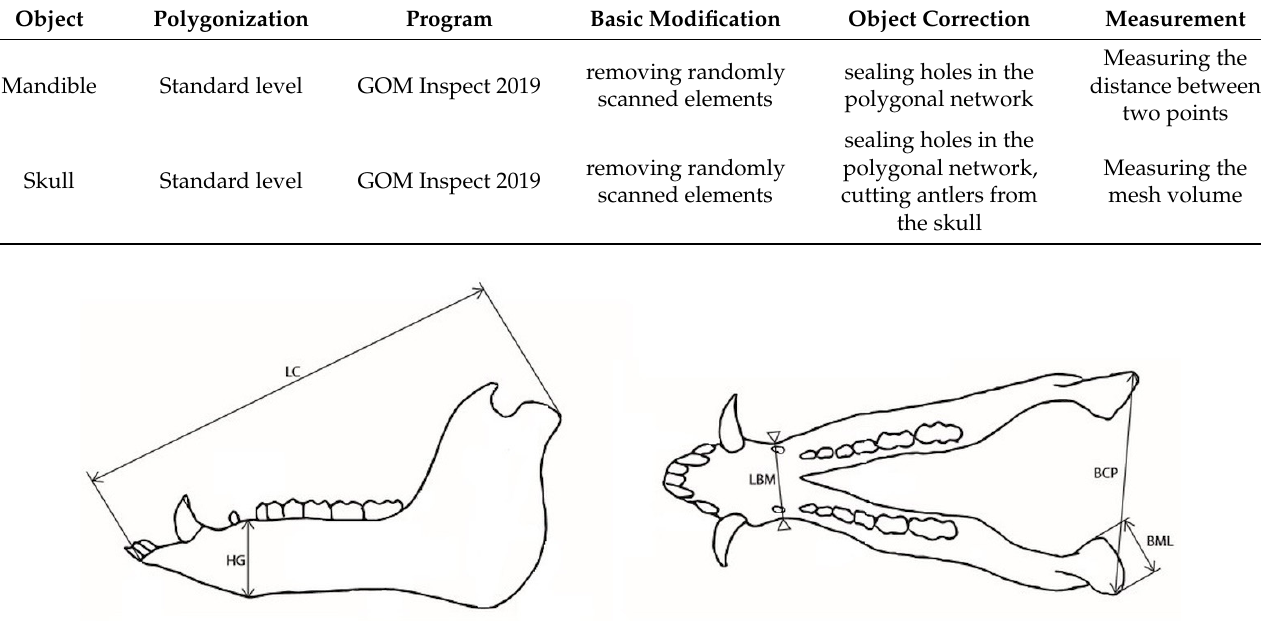
Figure 4. Dimensions measured on the mandible. Notes: LC—length of the cranium (condylobasal length), from the front part of pars incisive to anterior-most point of the processus condylaris; HG—height of the mandible, from the bottom of the symphysis mandibulae to the top of the margo interalveolaris; LBM—minimum breadth of the mandible; BCP—breadth of the mandible, between the borders of the medial and lateral points of the caput mandibulae; BML—breadth of the caput mandibulae.